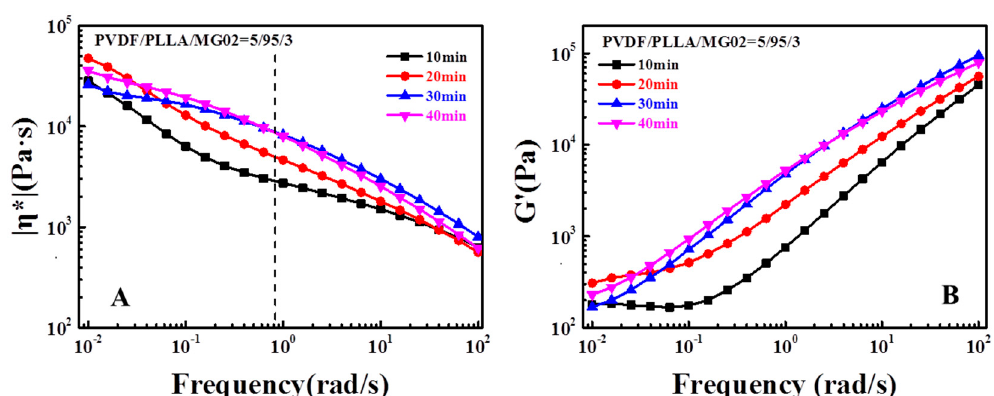
Figure 7. Complex viscosity ( A ), storage modulus ( B ) as a function of frequency at 200 °C for PVDF/PLLA various compatibilizers and mixing time.